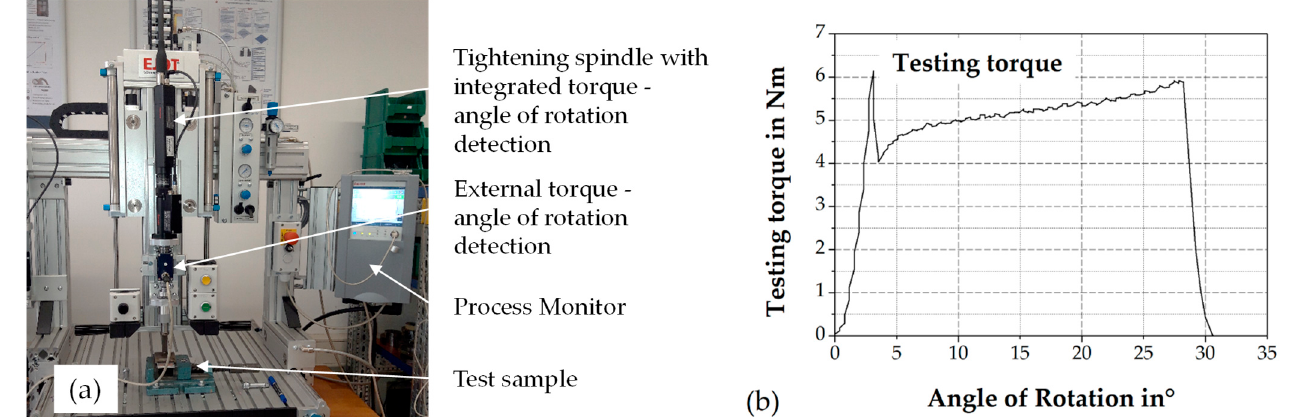
Figure 3. Torsion test setup ( a ) and characteristic testing curve ( b ).